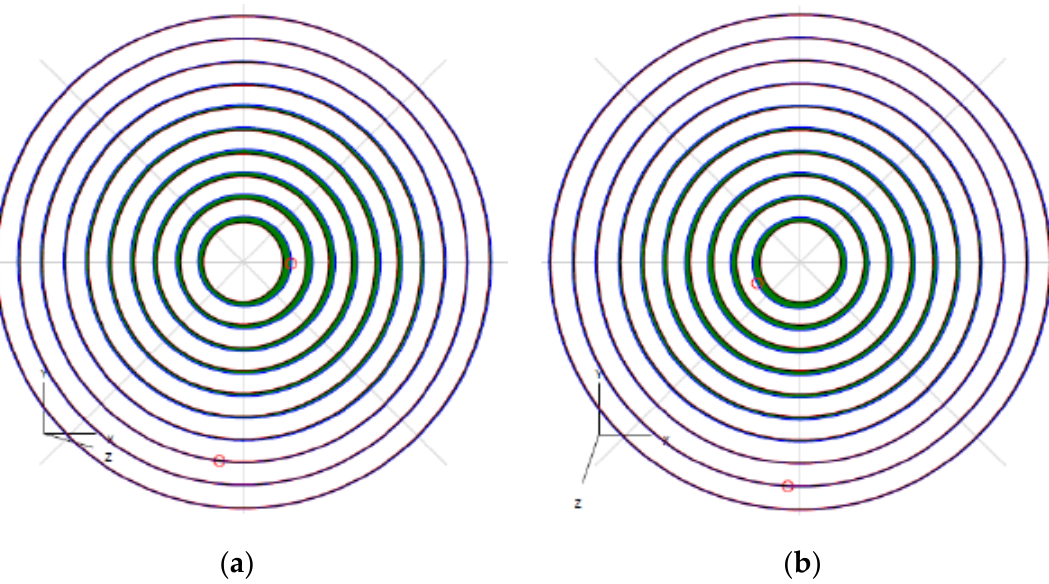
Figure 19. Cylindricity deviations ( a ) constant stepover-pocket auto border; ( b ) spiral strategy.